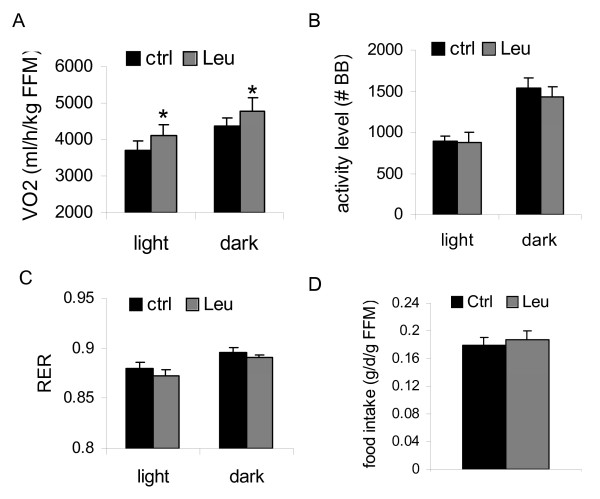
Leucine supplementation increases the resting metabolic rates in Aymice. A-C: rates of oxygen consumption (A), locomotive activities (B) and respiratory exchange ratio (RER, VCO2/VO2) (C) in the light and dark cycles in young Ay mice at the end of 4 month treatment. D. Food intake per unit of fat-free body mass (FFM) during the indirect calorimetric analysis. * indicates p < 0.05, control vs. leucine-treated, n = 8.